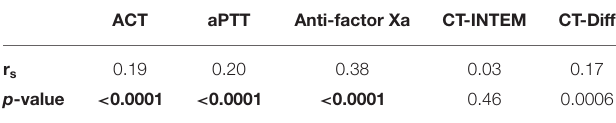
TABLE 2 | Spearman correlation coefficients between heparin dose and the different coagulation